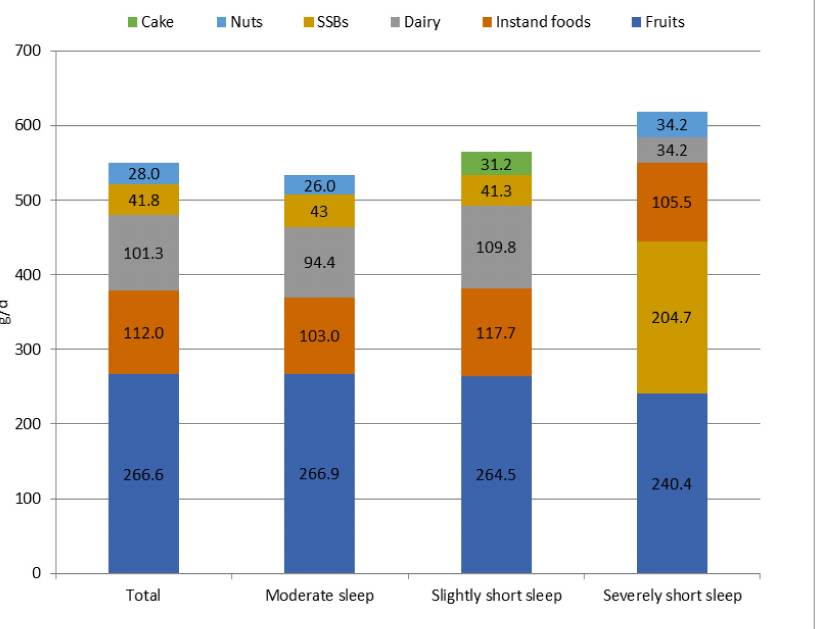
Figure 2. The top 5 snack types with highest daily intake in children with different sleep